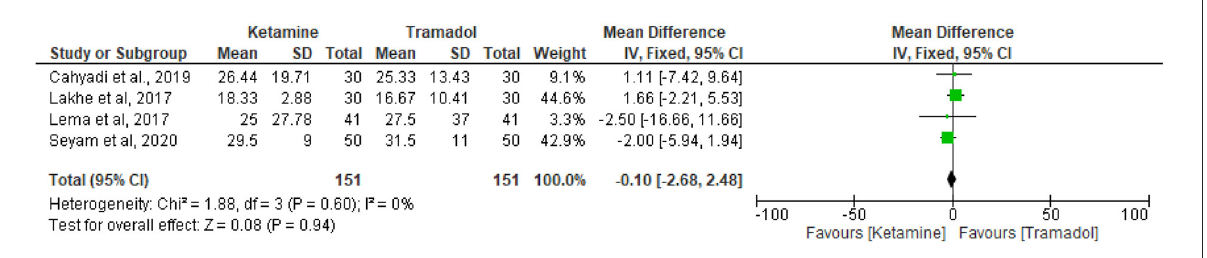
FIGURE5 The effect of tramadol vs. ketamine on onset of shivering.